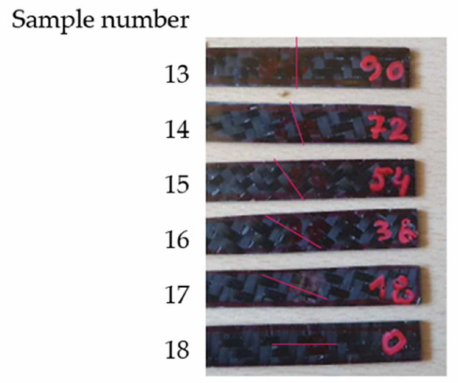
Figure 5. Samples 13–18 with orientations of warp fibres: 0 ◦ , 18 ◦ , 36 ◦ , 54 ◦ , 72 ◦ , and 90 ◦